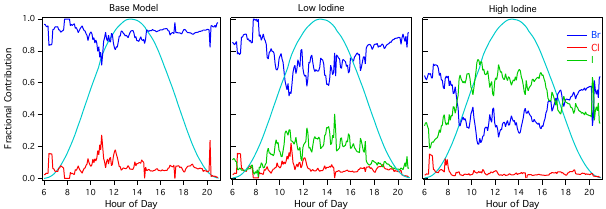
Figure 5. Average diurnal cycles of the fraction of O 3 depleted by Br, Cl and I atoms for the Base Model scenario, the Base + Low Iodine scenario and the Base + High Iodine scenario. Br is shown in the blue trace, Cl in the red trace, and I in the green trace; radiation is shown in the cyan trace as a reference. Data shown are only for periods when O 3 >5ppbv. Time is expressed in Alaska Standard